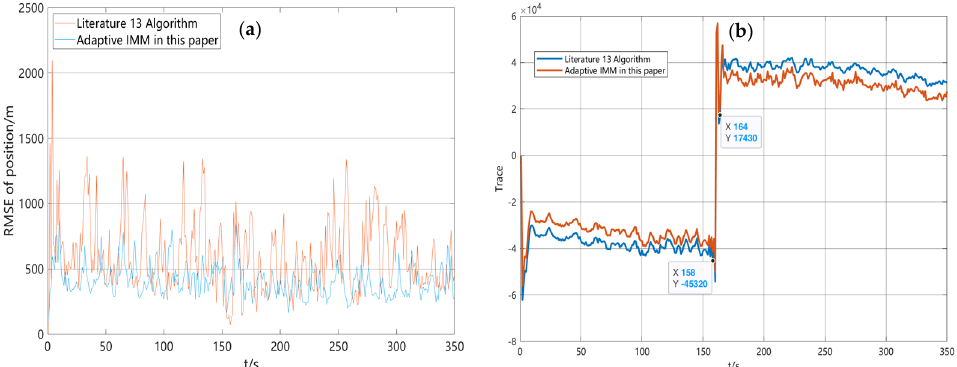
Figure 8. Trajectory tracking of hypersonic target. ( a ) Hypersonic target strong maneuver phase; ( b )